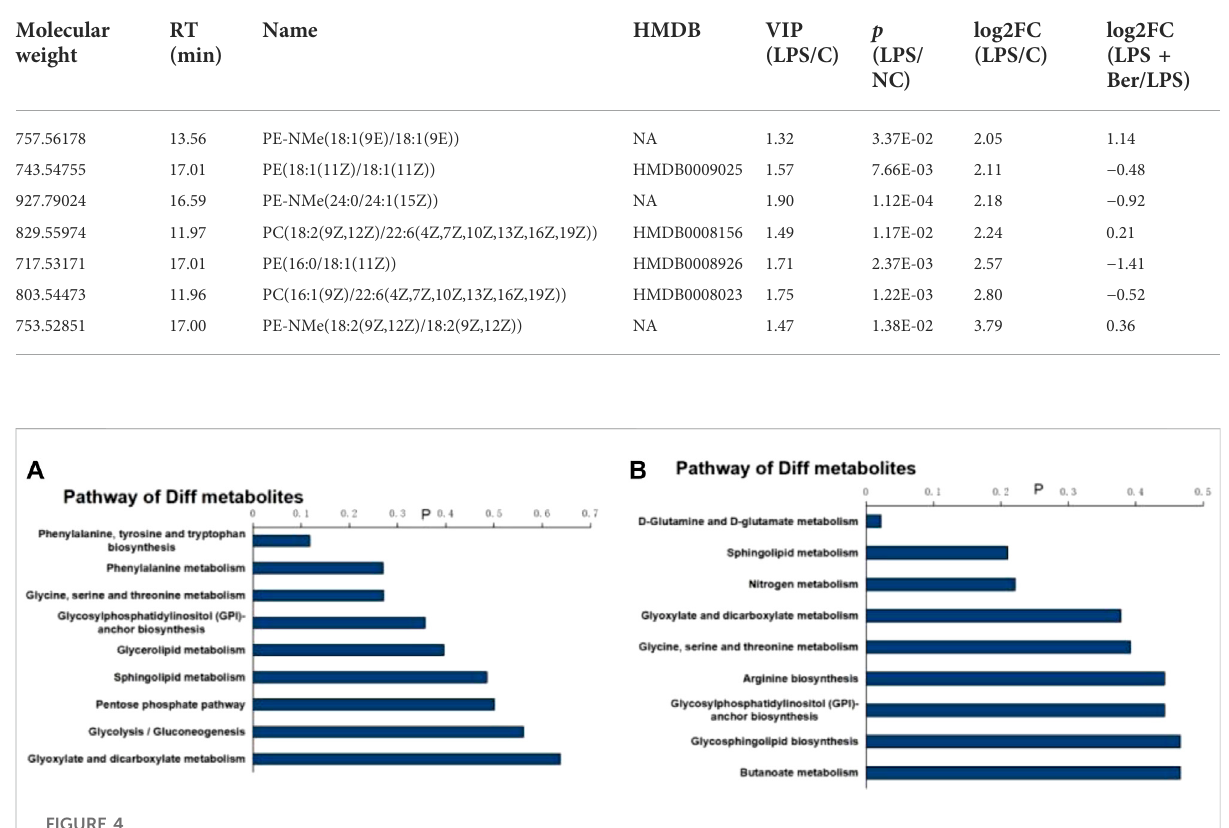
FIGURE 4 Pathway analysis of differential metabolites. (A) Bar chart of the metabolic pathway of NC versus LPS. (B) Bar chart of the metabolic pathway of LPS + Ber versus